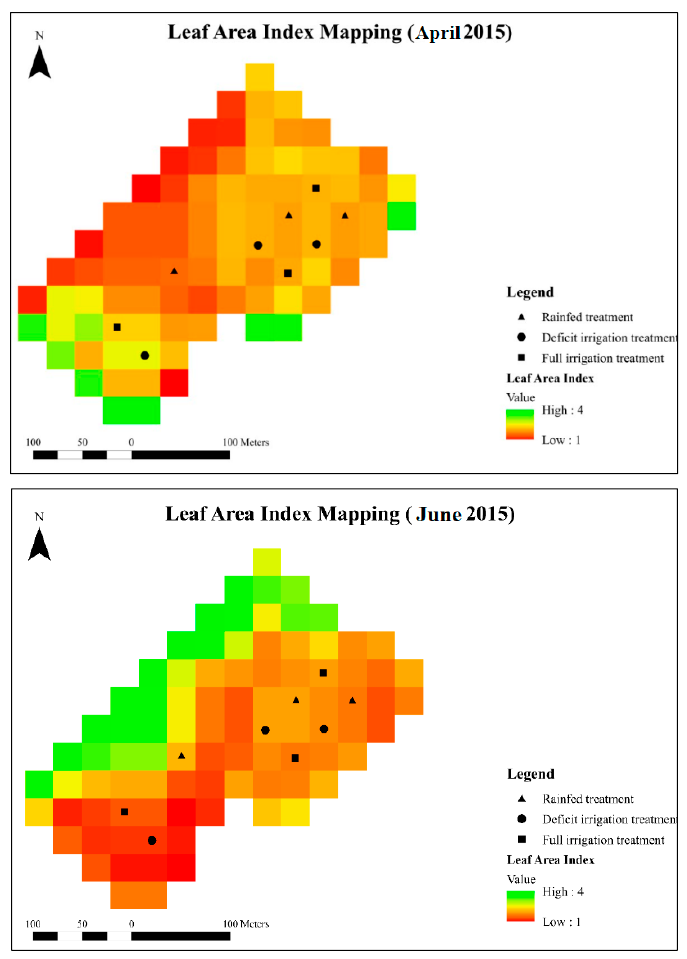
Figure 5. Leaf Area Index (LAI) maps made using LANDSAT 8 on 16 April and 03 June 2015.